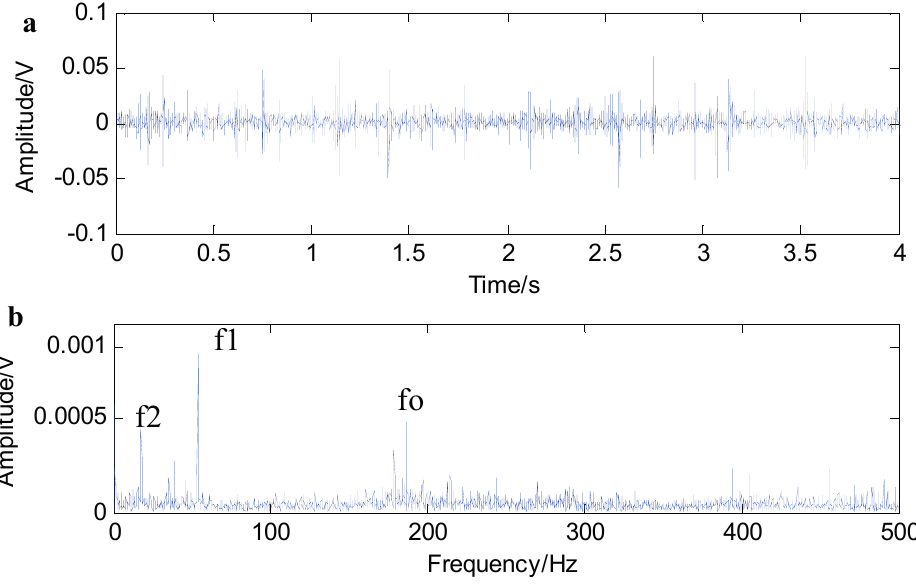
Figure 15. Time waveform of the filtered signal with an outer race defect using fast NL-Means ( a ); and the envelope spectrum of the filtered signal ( b